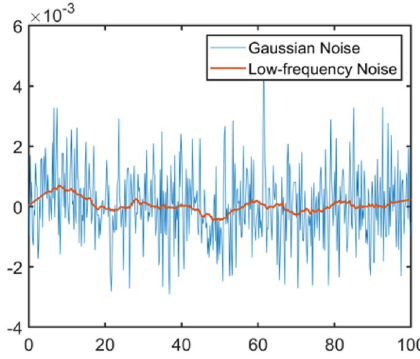
Figure 4. Gaussian noise and filtered noise.